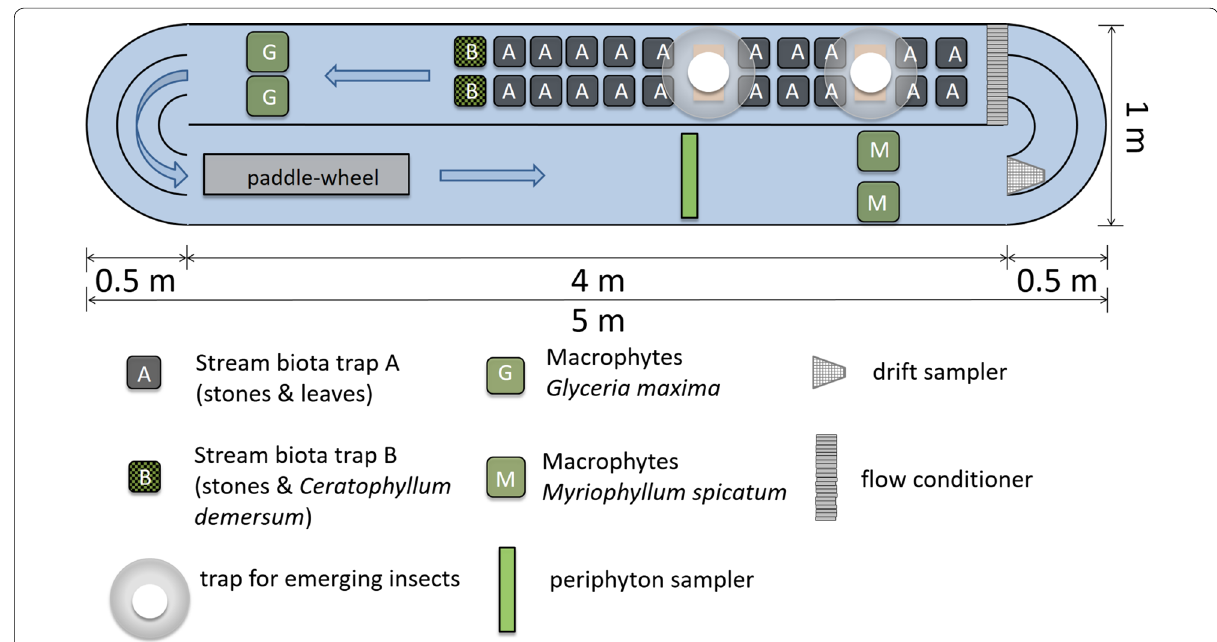
Fig. 1 Experimental setup of one stream mesocosm with different sampling end